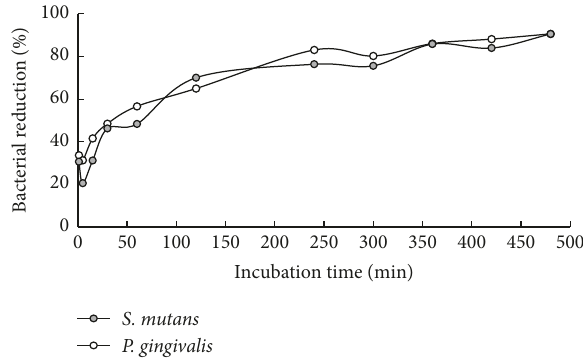
Figure 4: Antibacterial effect at 50 𝜇 moLL −1 of CatDex. Percentage of bacterial reduction of S. mutans UA130 and P. gingivalis W83 over time ( 𝑝 ≤ 0.05